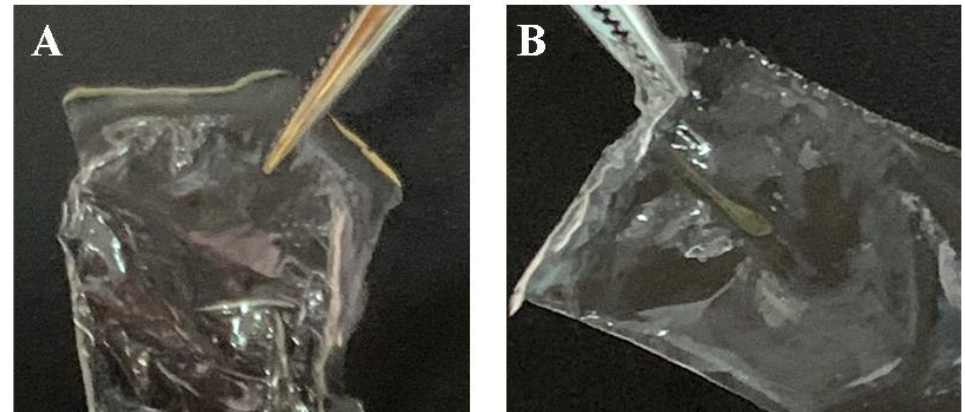
Figure 2. Scaffolds based on silk fibroin. ( A ) Scaffold in the form of a film based on silk fibroin (SF), ( B ) scaffold in the form of a film based on silk fibroin, with microparticles of decellularized rat liver tissue included in the composition (SF-MP).